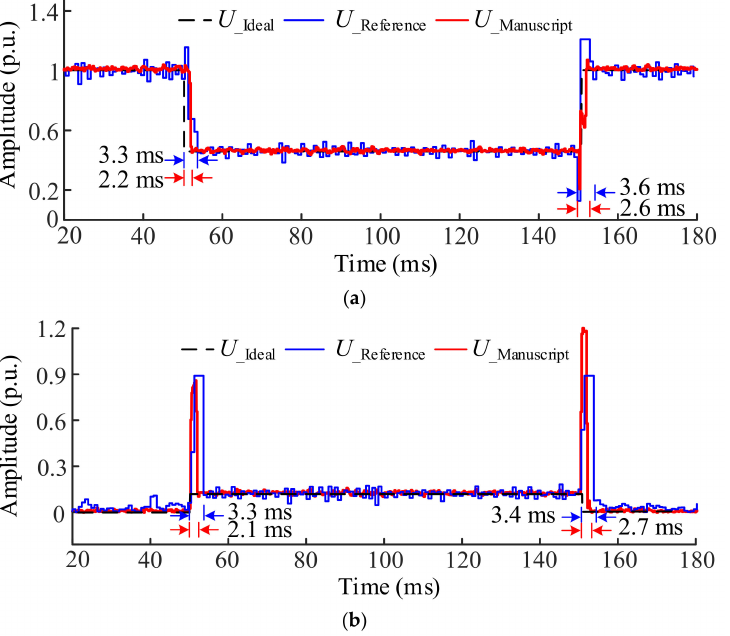
Figure 12. Comparison of positive-sequence and negative-sequence voltage amplitude detection results ( a ) positive-sequence component of three-phase voltage; ( b ) negative-sequence component of three-phase